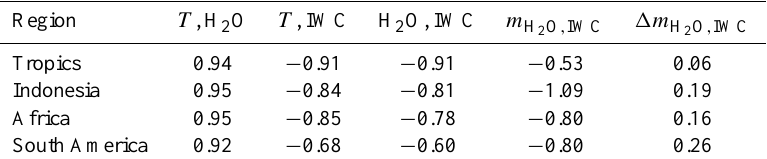
Table 1. Correlations of T , H 2 O and ice water content (IWC) in different regions. Tropics (zonal mean 8 ◦ S–8 ◦ N), Indonesia (12 ◦ S– 8 ◦ N, 100 ◦ E–180 ◦ E), Africa (8 ◦ S–8 ◦ N, 8 ◦ W–24 ◦ E), South America (8 ◦ S–8 ◦ N, 80 ◦ W–50 ◦ W). The first column shows that 100hPa temperature and water vapor are highly correlated. T and IWC are strongly anticorrelated with a smaller value over South America though. The third, fourth and fifth column show the correlation of H 2 O and IWC, the slope of the regression line as shown in Fig. 5 as well as the 2 σ uncertainty of the slope. The anticorrelation is high with lower values over South America. The slope in the selected regions is between − 0.80 and − 1.09 which is fairly close to the expected − 1 if water transforms totally from ice to vapor and back.